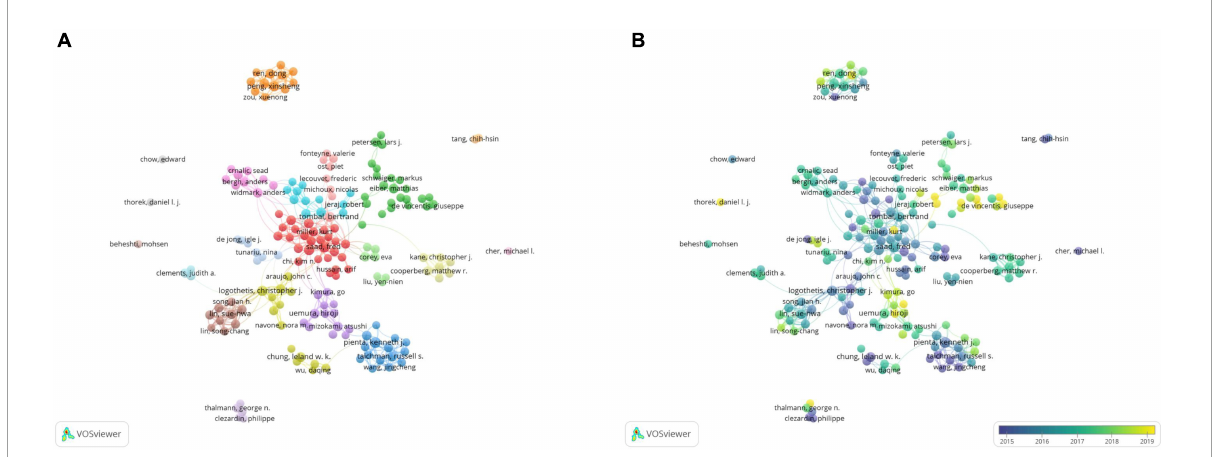
FIGURE4 The bibliometric analysis of the co-authorship of authors in the field of PCa bone metastasis. (A) The network visualization map of authors collaboration in the field of PCa bone metastasis. (B) The overlay visualization map of authors collaboration in the field of PCa bone metastasis.